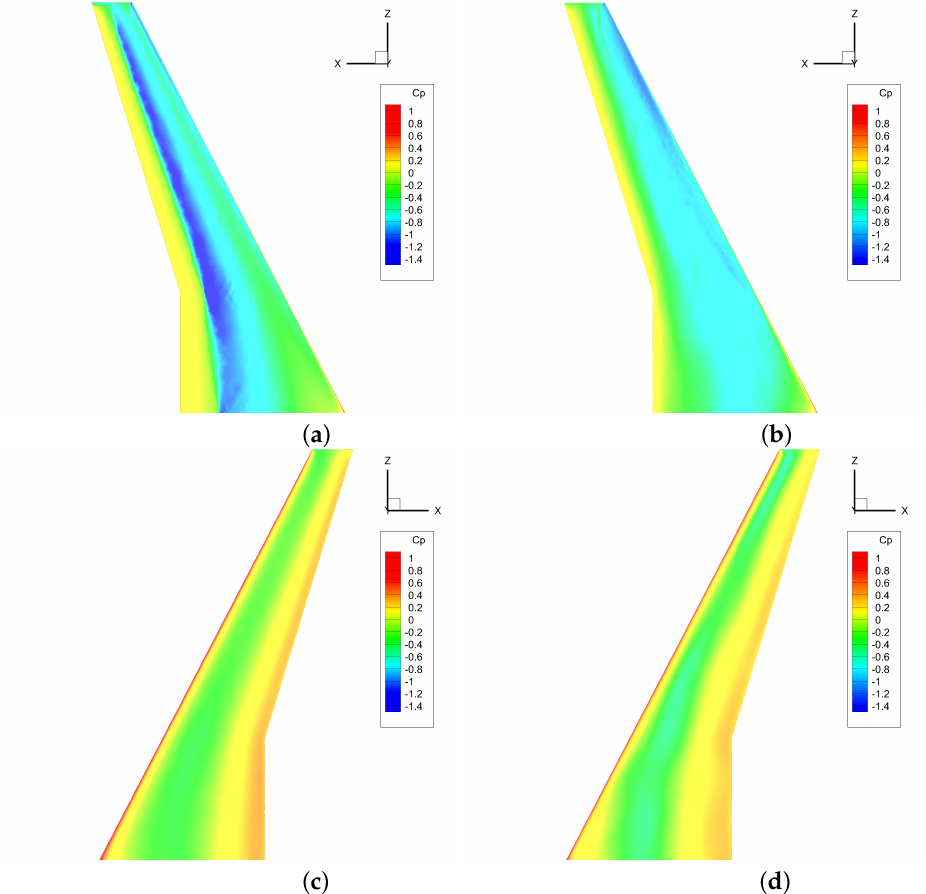
Figure 8. ( a ) Pressure coefficient contours on the wing upper surface of the initial wing; ( b ) Pressure coefficient contours on the wing upper surface of the optimized wing; ( c ) Pressure coefficient contours on the wing lower surface of the initial wing; ( d ) Pressure coefficient contours on the wing lower surface of the optimized